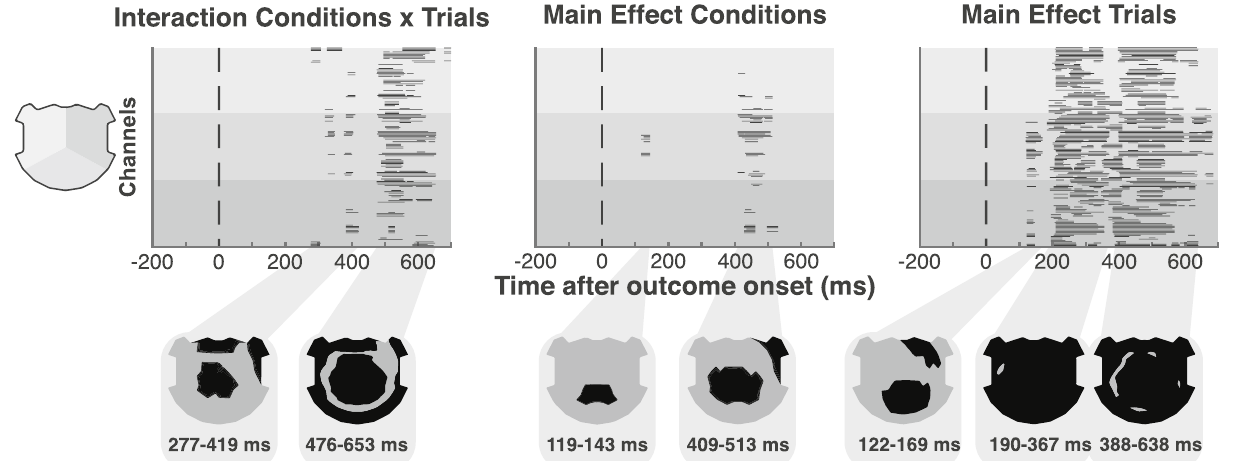
Figure 2. Global waveform analysis. Results of time-wise amplitude differences over all 156 electrodes show the interaction between condition and trials (left), the main effect of condition (middle) and the main effect of trials (right) of the 2 × 3 rmANOVA. Electrodes with significant differences (p < 0.01; ≥ 20 ms) are displayed in